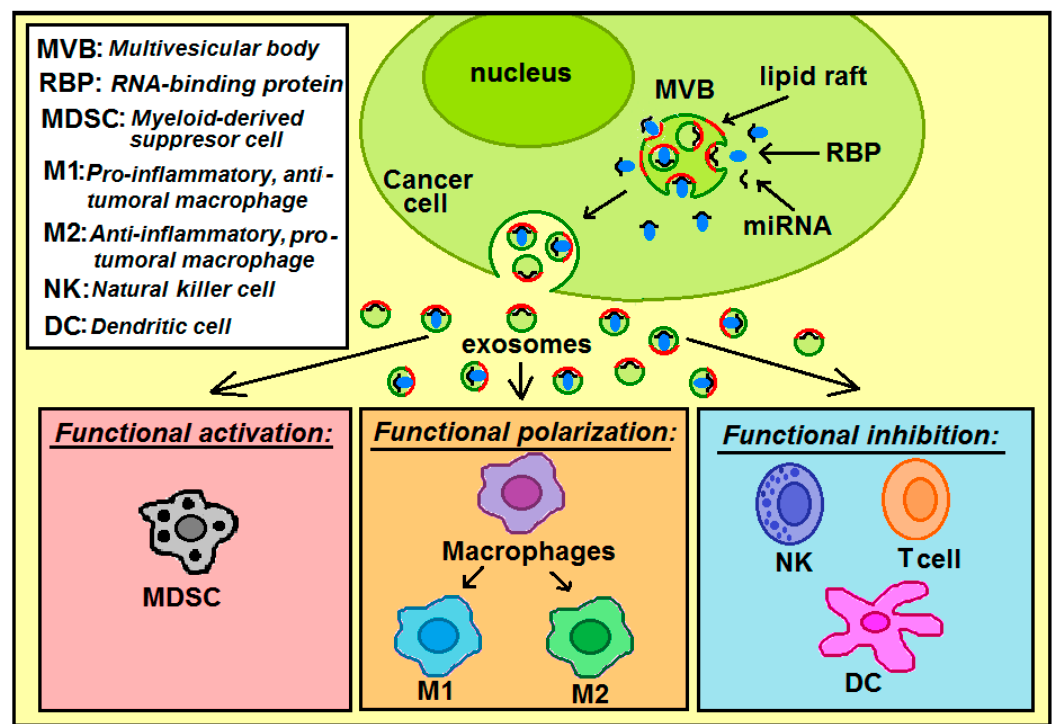
Figure 7. The pathway of miRNAs: from the loading process into exosomes within cancer cell, release into extracellular space, transport, and internalization into immune cells. Within the immune cells, exosomal miRNAs can act through functional activation, functional polarization or functional